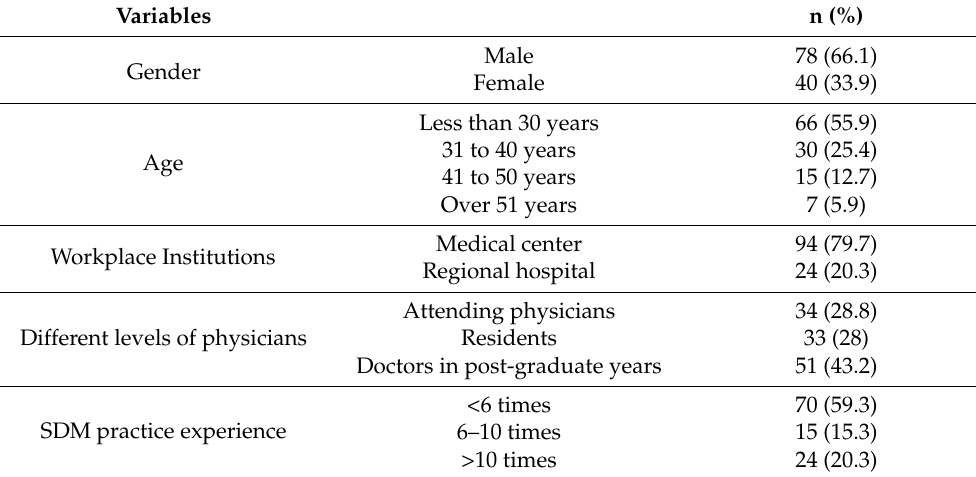
Table 2. The sociodemographic characteristics of valid samples (N = 118).